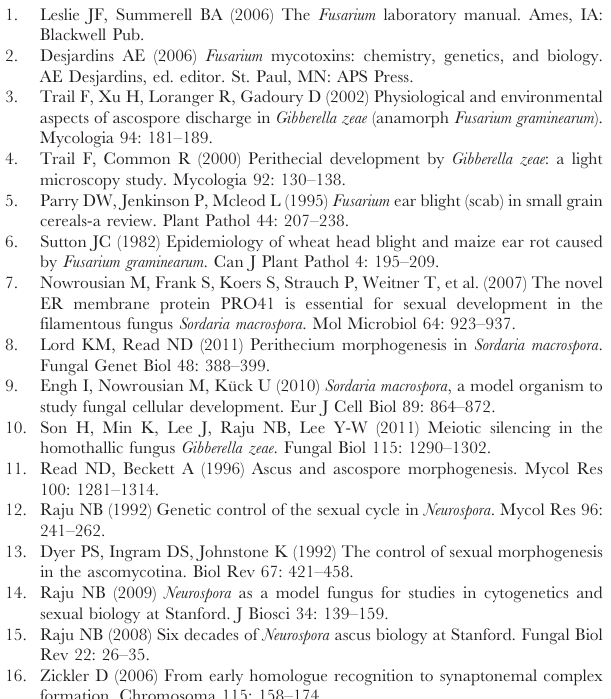
Table S1 Primers used in this study.